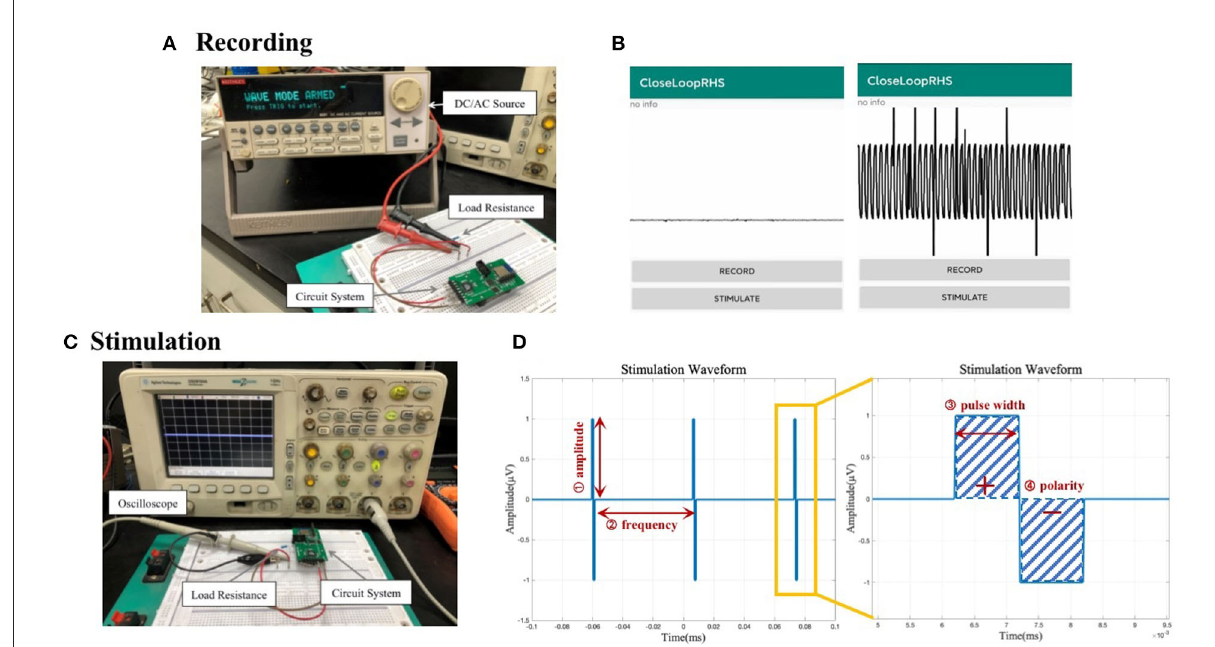
FIGURE6 (A) Circuit connection diagram for the system recording functional test. (B) Waveform display of the data recorded by the system acquisition function on the mobile phone. (C) Circuit connection diagram for system stimulation functional test. (D) Illustration of output stimulus with adjustable parameters: amplitude, frequency, pulse width, and